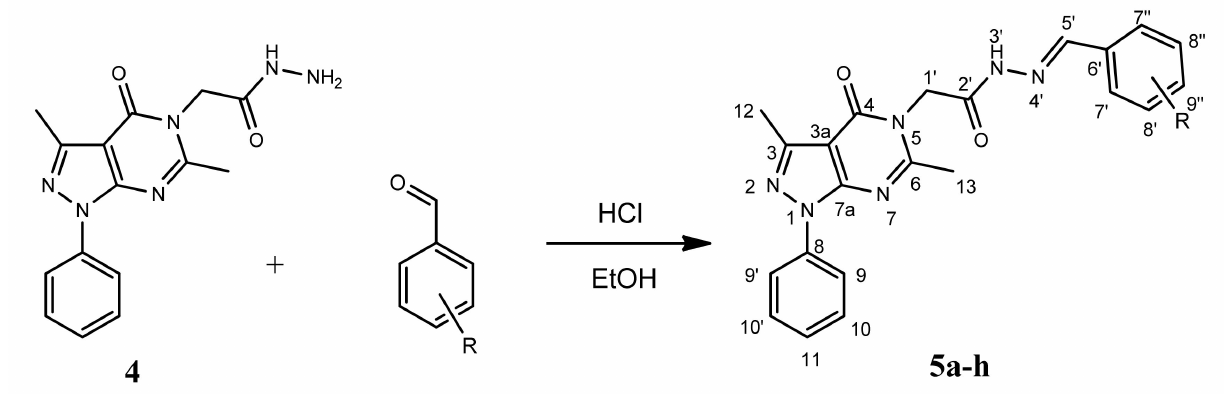
Scheme 2. Synthetic pathway of pyrazolopyrimidinones 5a – h